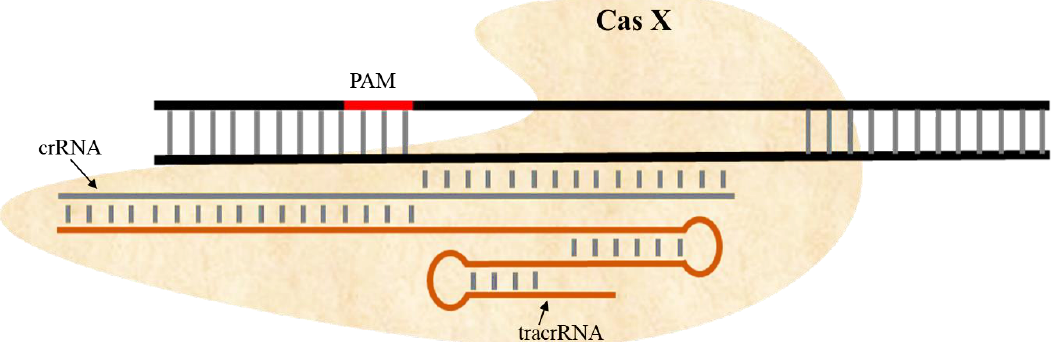
Figure 4. Schematic diagram of CRISPR/CasX. CasX is a dual-guided RNA enzyme utilizing crRNA and tracrRNA. It binds and cleaves dsDNA adjacent to an appropriate PAM site.